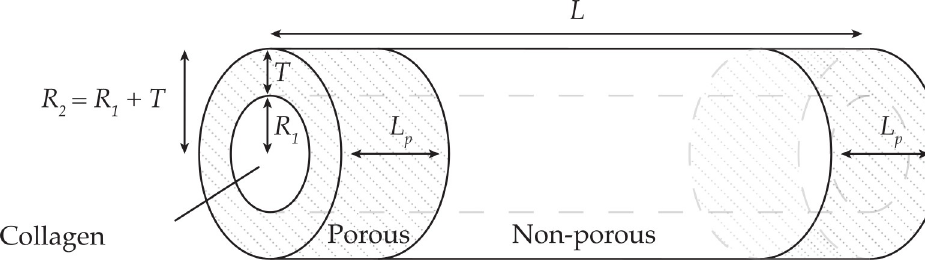
Fig 1. Nerve repair construct geometry. Sheath partially made of porous material permeable to molecular exchanges at the construct extremities. The parameter R 1 denotes the radius of the cell-seeded collagen cylindrical core, T the thickness of the sheath, R 2 = R 1 + T the radius of the nerve repair construct, L the length of the construct and L length of the porous section of the sheath (2 L p in